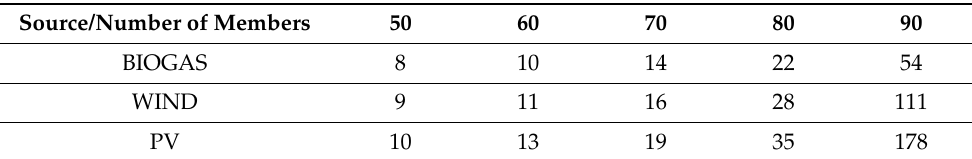
Table 6. The average error of estimating theoretical curves with respect to the data measured. The error is expressed in the number of members of the